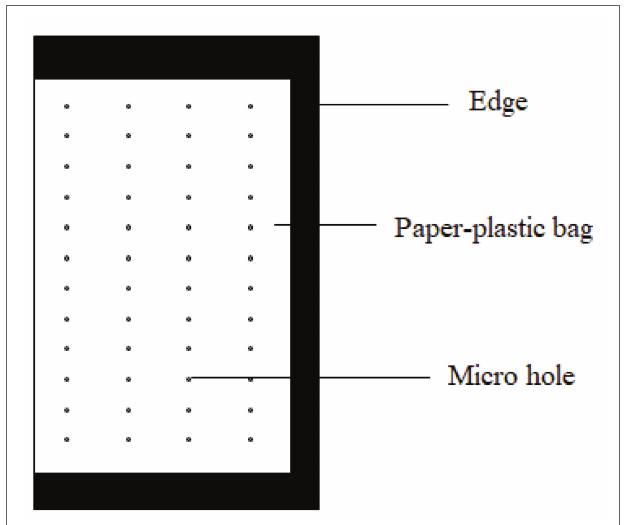
FIGURE 1 | Bag of bag-controlled release fertilizer (BCRF).